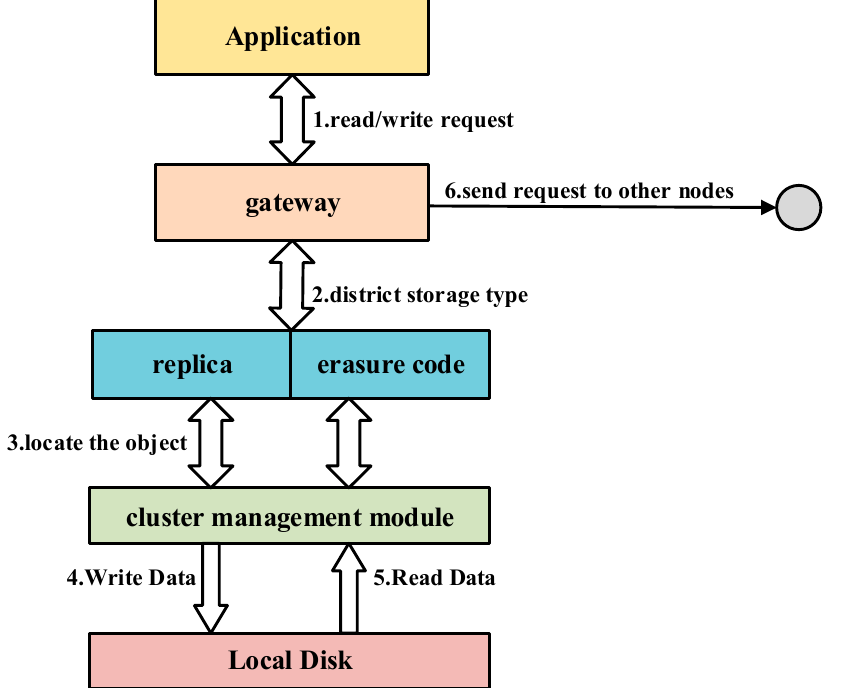
Figure 7. The architecture of the system.